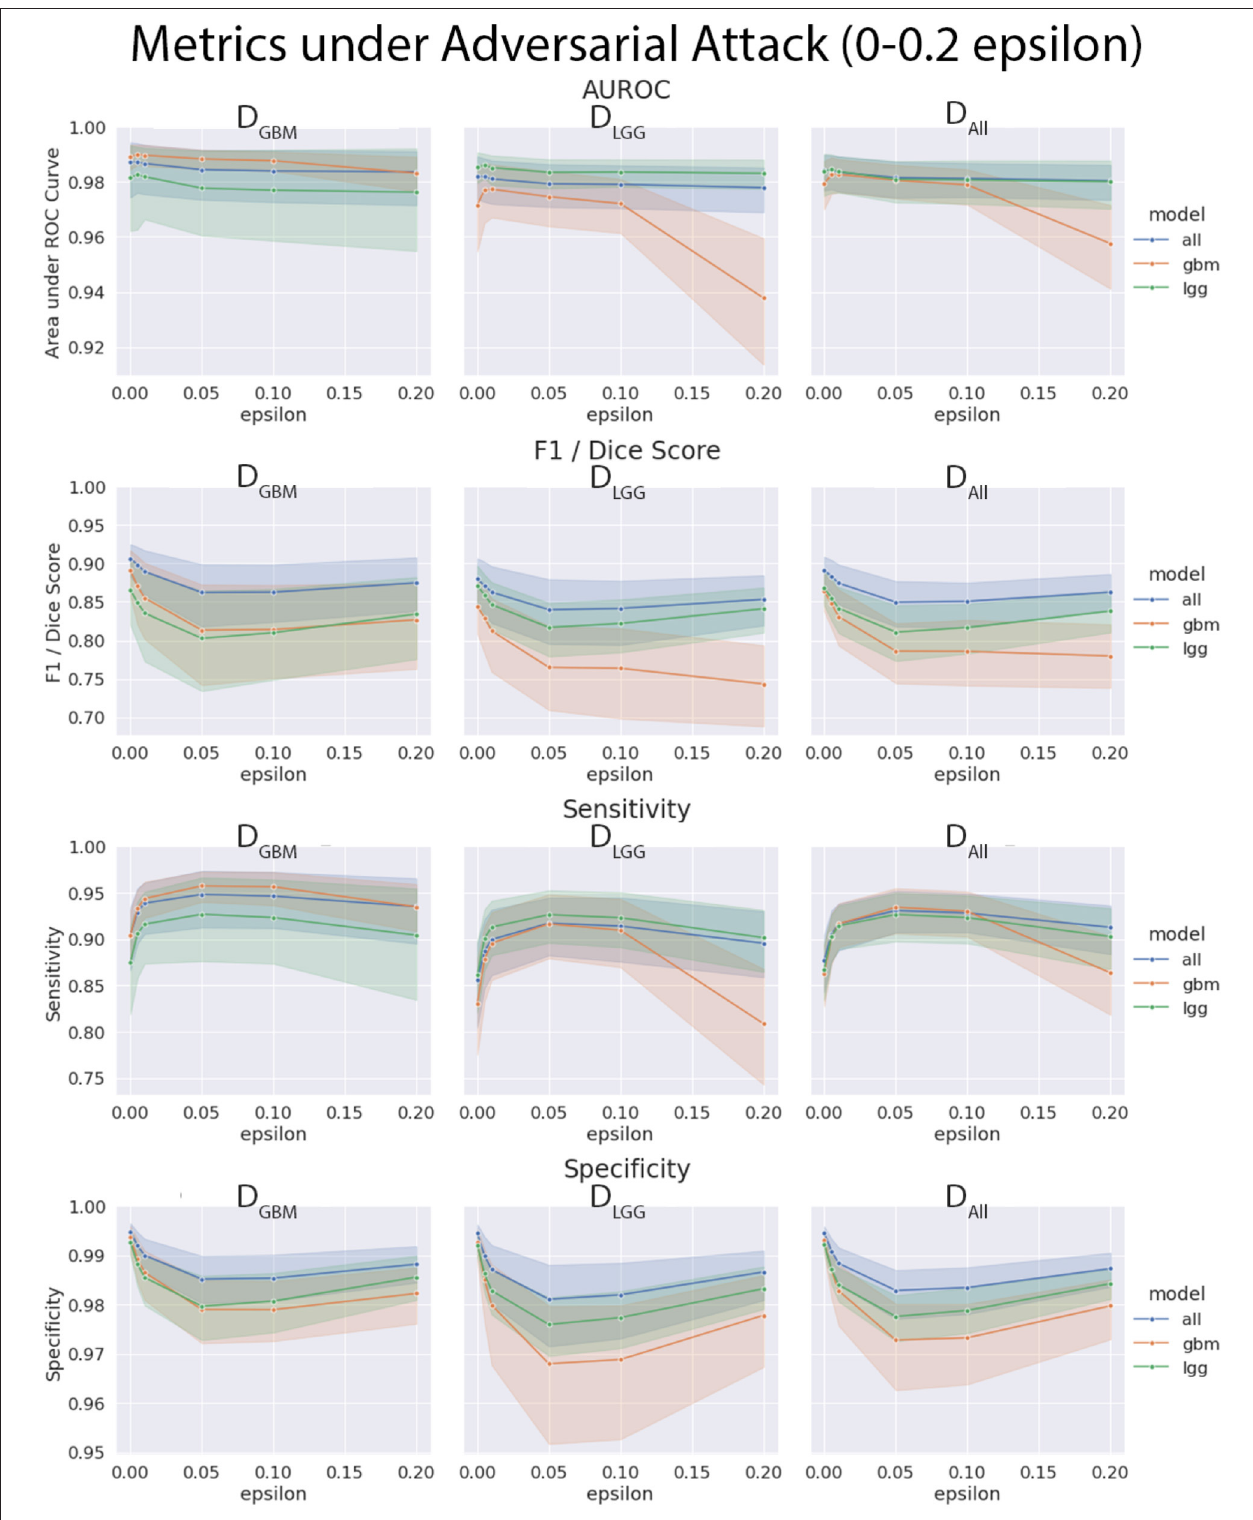
FIGURE 11 | Robustness of each model under FGSM attack, zoomed in on the early range of epsilons (0–0.2) for four selected metrics. Ninety-five percent confidence intervals are provided to each model, and each of the three data sets were evaluated. Models had more similar performance in the less aggressive levels of attack, with all model having marginally better performance, except with M LGG and M GBM models performing better with AUROC on their own test data sets.